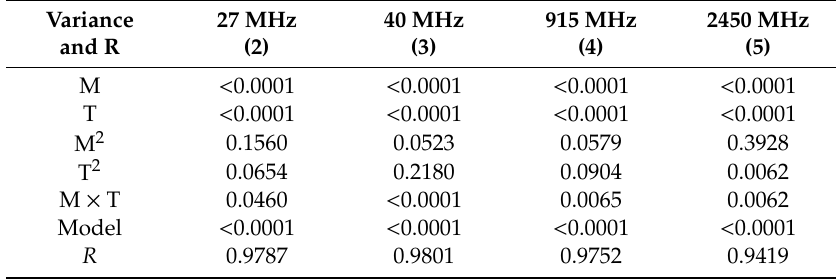
Table 5. Significance of the probability of the regressed models in Equations (2)–(5) for the pecan kernel samples at four specific frequencies.